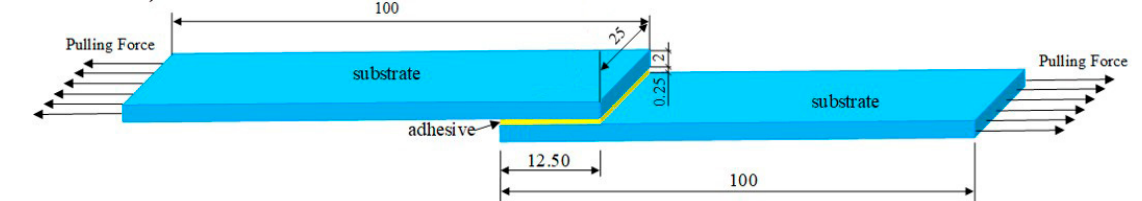
Figure 1. Form and dimensions of adhesive joints (mm).